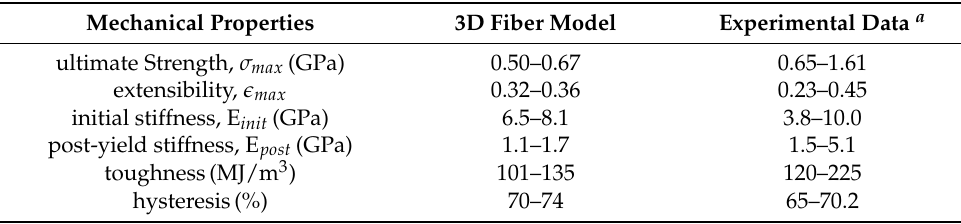
Table 2. Comparison of mechanical properties observed through 3D fiber model simulations and experimental